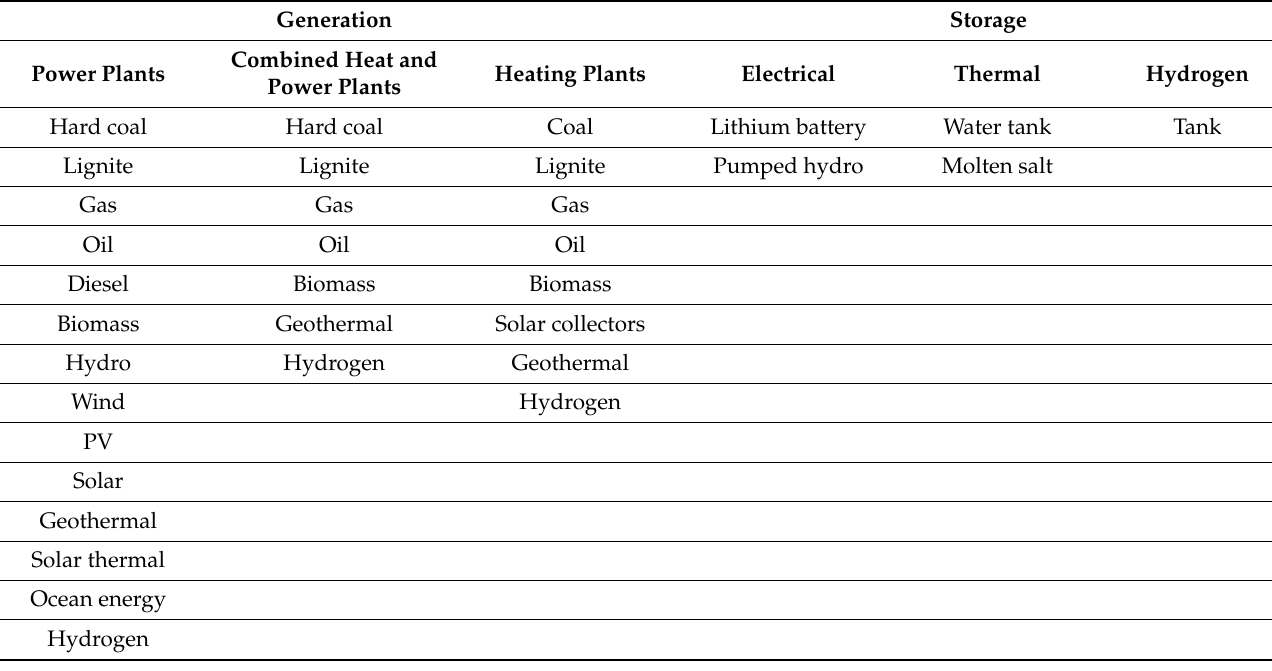
Table 6. Example of generation and storage technologies.